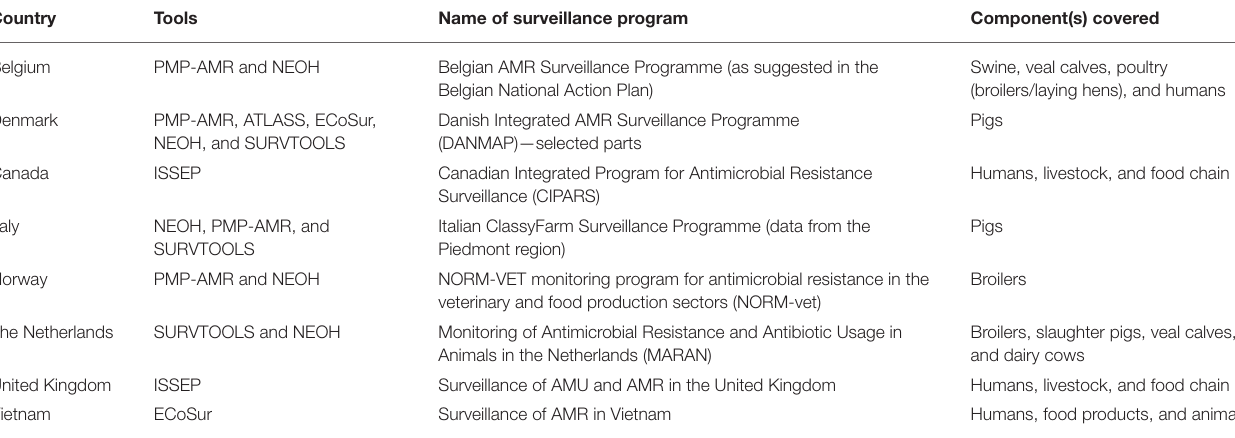
TABLE 1 | Overview of eight country-based case studies involving six different tools for evaluation of surveillance of antimicrobial use and resistance, 2019.